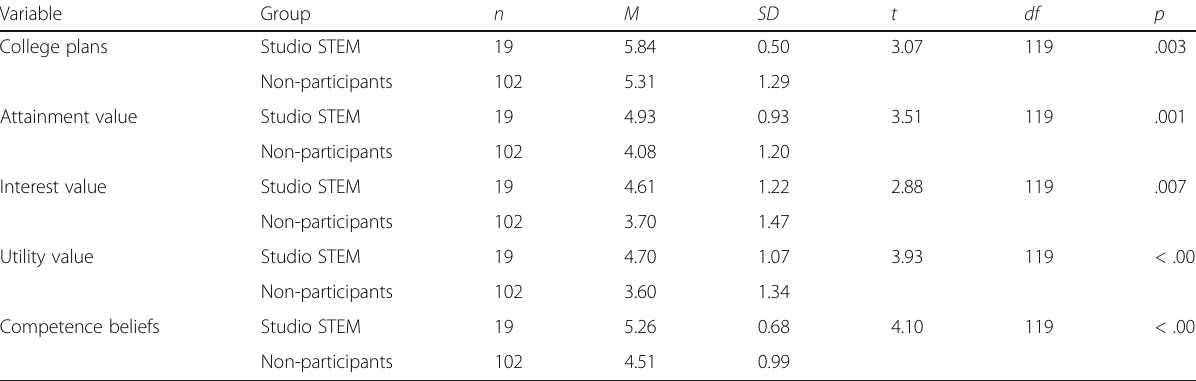
Table 4 Comparing Studio STEM participants and non-participants after program implementation Variable College plans